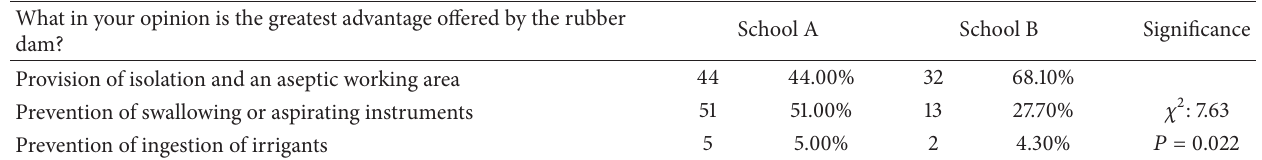
Table 2: Opinions of students about the usage of rubber dam.